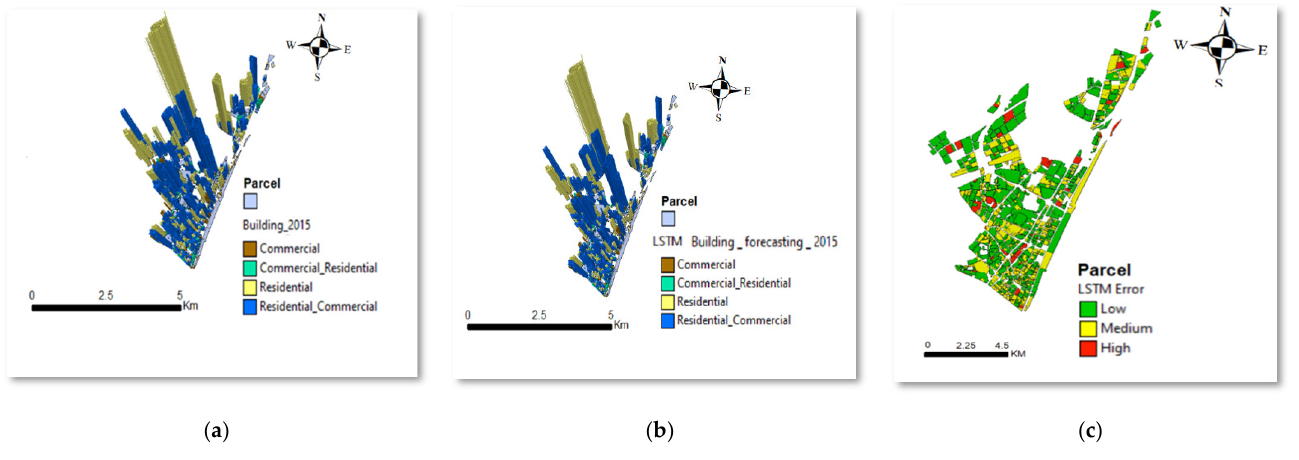
Figure 14. ( a – c ). The predicted results from the MLP and LSTM models and the difference error between the observed and predicted building quantities at the parcel level: ( a ) building type at parcel level 2015 (observed); ( b ) LSTM model prediction; and ( c ) difference error between actual building type 2015 and LSTM model prediction.